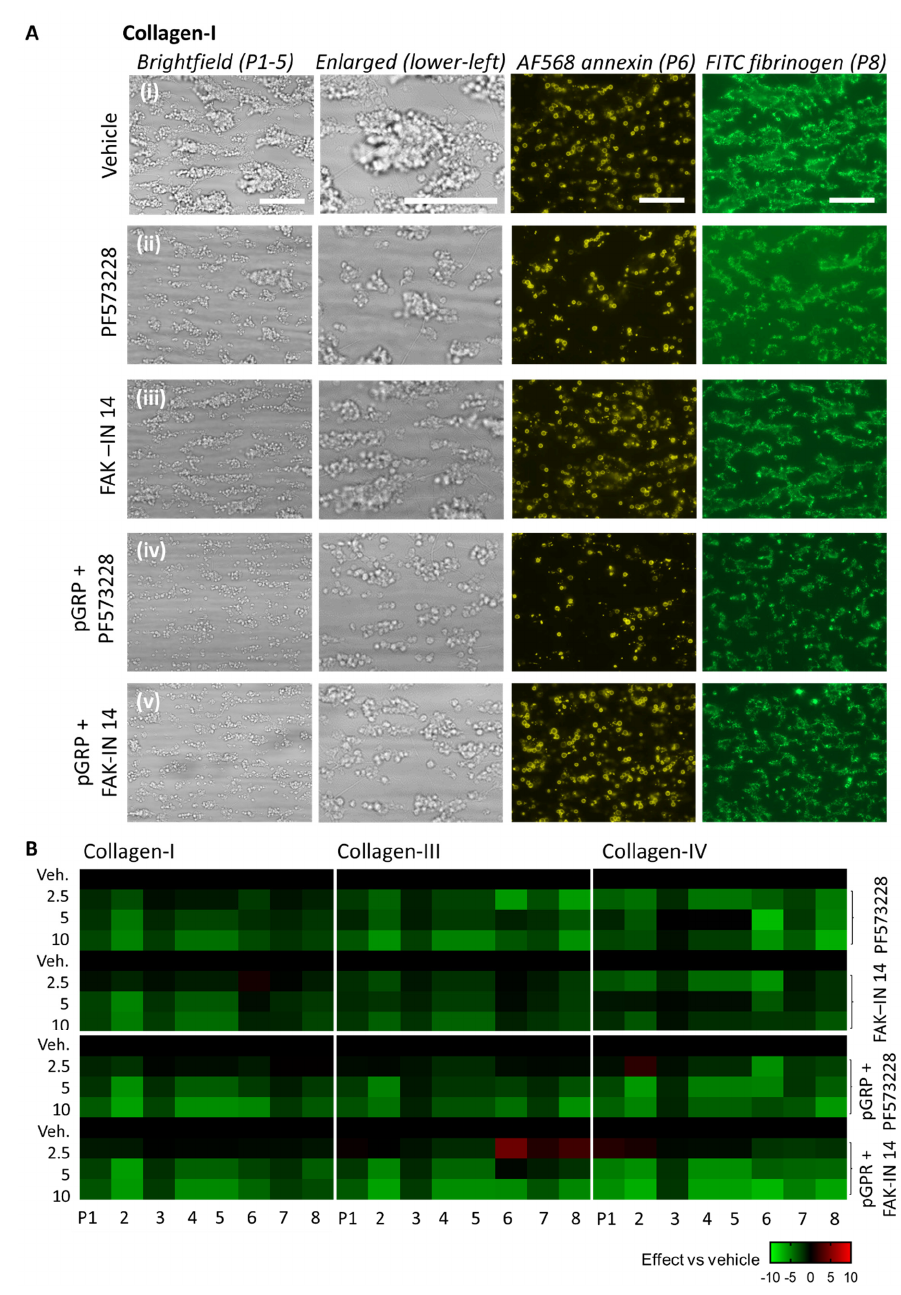
Figure 3. Effects of GPR56-binding peptide and PTK2 inhibition on collagen-induced thrombus formation. Whole blood samples were pre-incubated with vehicle medium (control) or indicated PTK2 inhibitor (PF573228 or FAK-IN14 at 2.5–10 µ M) with or without pGRP peptide (50 µ g/mL) for 10 min. After recalcification, the blood was perfused over collagen I, III, and IV for 3.5 min at a standard shear rate of 1000 s − 1 . End-stage brightfield and fluorescence images were analyzed for thrombus parameters P1–8. Enlarged images (lower-left corner) are indicated to visualize the formed platelet aggregates. ( A ) Representative images for collagen I of ( i ) vehicle control, ( ii ) PF573228 (10 µ M), ( iii ) FAK-IN14 (10 µ M), ( iv ) pGRP + PF573228 runs, and ( v ) pGRP + FAK-IN14. Scale bar = 10 µ m. Representative images for collagen III and collagen IV are shown in Figure S2. ( B ) Subtraction heatmap representing control-subtracted scaled (0–10) parameter values for collagen I, III, and IV microspots. The color code represents a decrease (green) or increase (red) in comparison to control runs. Means of duplicate runs for three donors were compared per blood sample. For statistics, see Figure